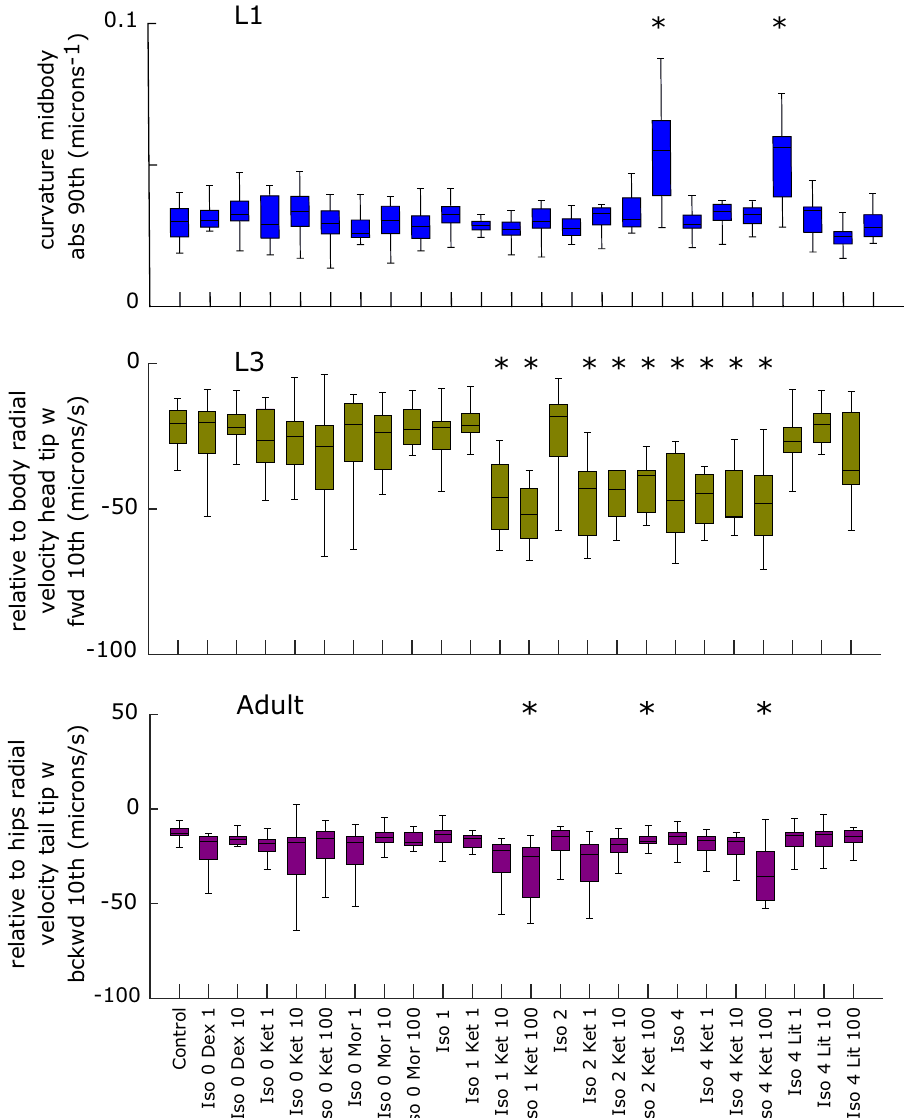
Figure 4. Examples of significant anaesthetic condition/behavioural feature differences at L1, L3 and adult. Combinations significantly different to control are marked with an asterix (p value limits as given in Fig. 3). Dex = dexmedetomidine, Ket = ketamine, Mor = morphine, Iso = isoflurane; Lit = lithium. Numbers refer to either isoflurane concentration in percent air, or drug concentration in